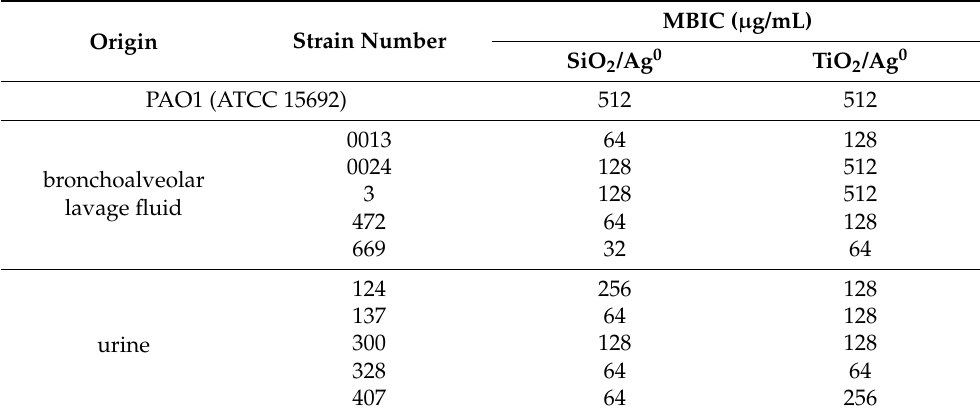
Table 4. Minimal biofilm inhibitory concentrations (MBICs) of SiO 2 /Ag 0 , TiO 2 /Ag 0 against P. aeruginosa